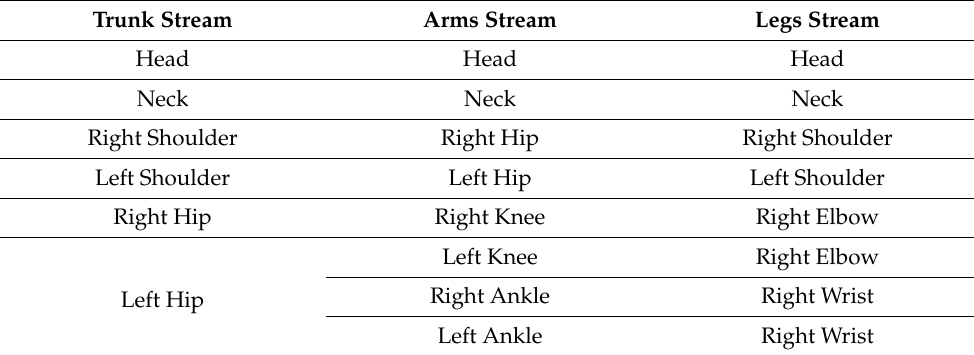
Table 2. The proposed network employs three streams that contain: trunk joints, arms joints, and legs